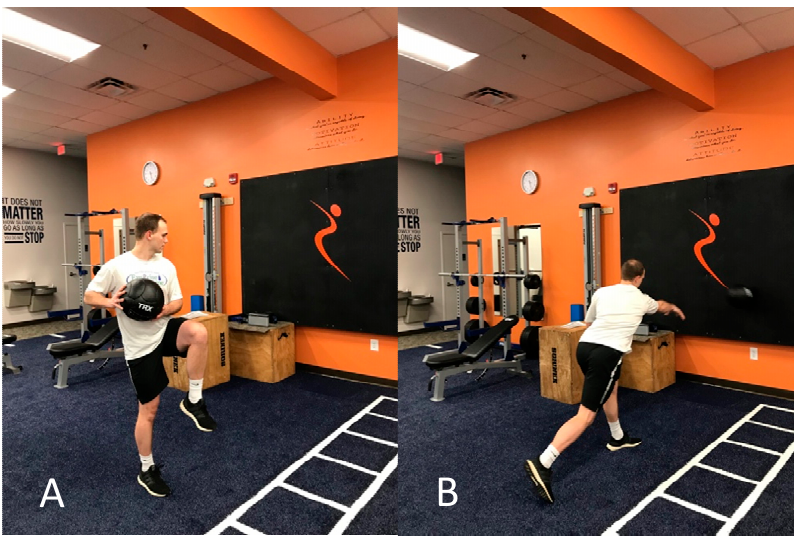
Figure 4. Plyometric medicine ball throw against wall. ( A ) Starting in wind-up position, ( B ) deceleration phase after ball release.